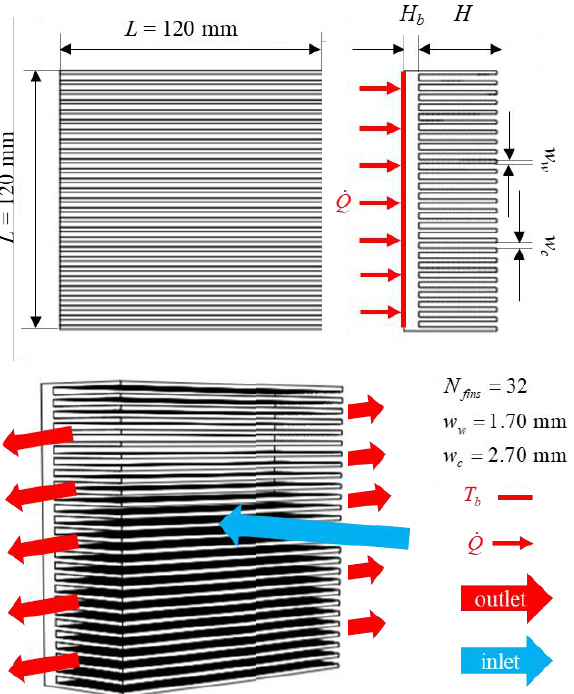
Figure 1. A sketch of the impinging-flow longitudinal finned heat sink to be optimized in this study.